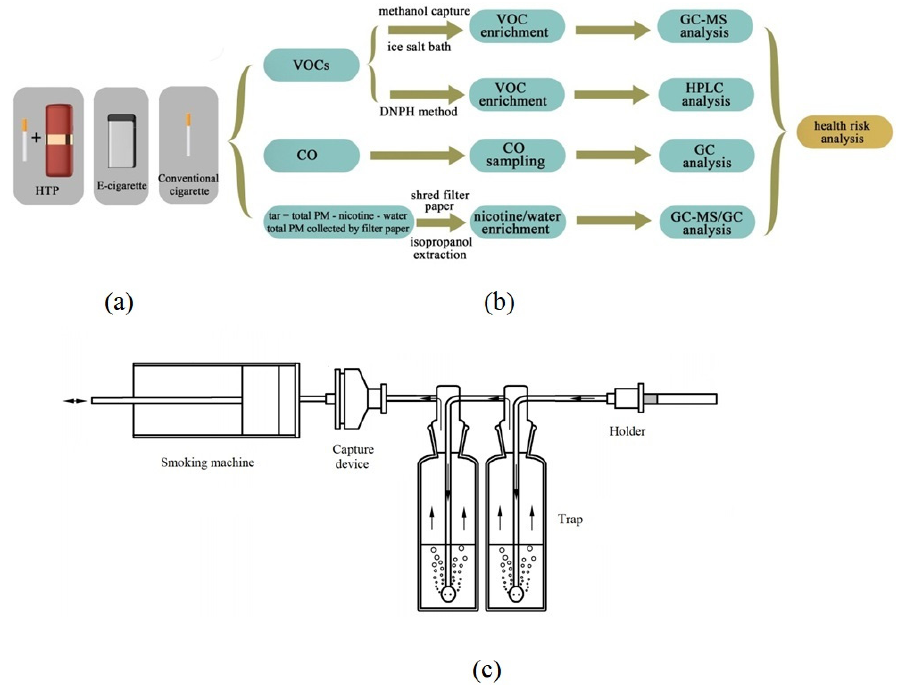
Figure 1. ( a ) Types of tobacco products used in this research; ( b ) Flow chart of the sampling proce- dure; ( c ) Device for mainstream aerosol